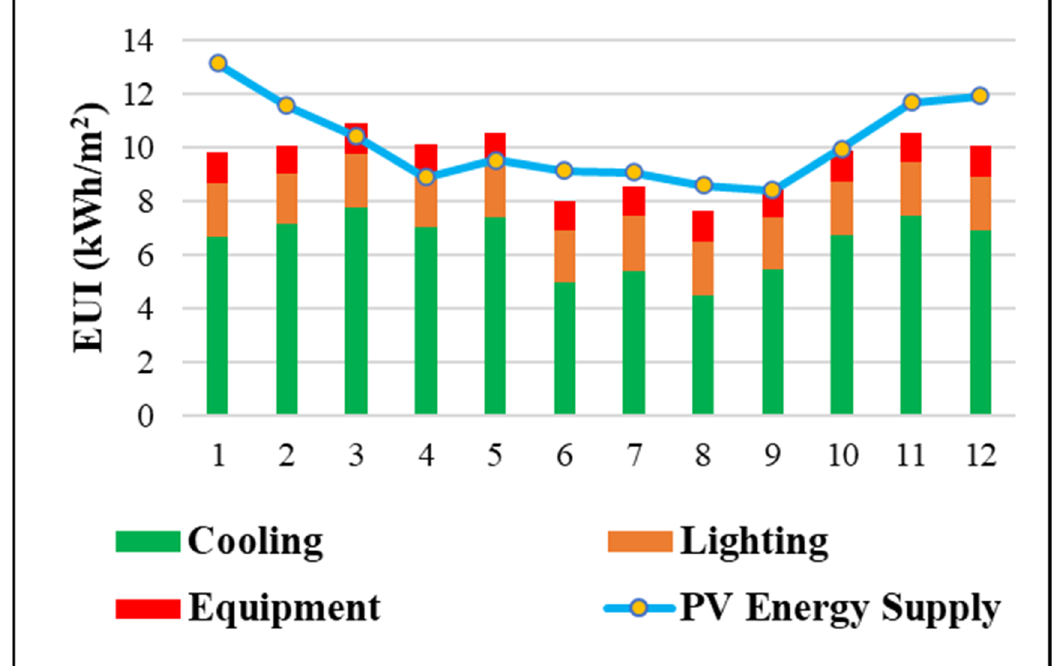
Figure 8. Total operational energy use against PV energy supply.